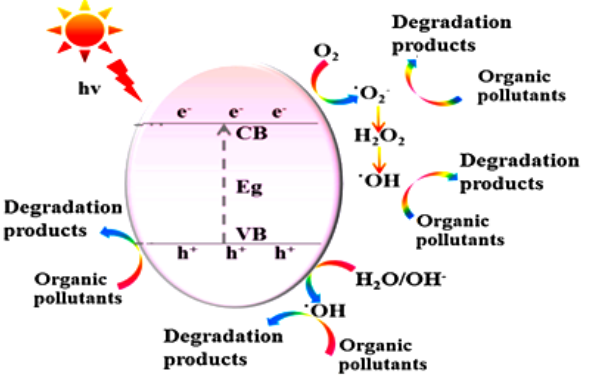
Figure 4. General mechanism of photocatalysis, depicting the generation of holes (h + ) and electrons (e − ) [80].